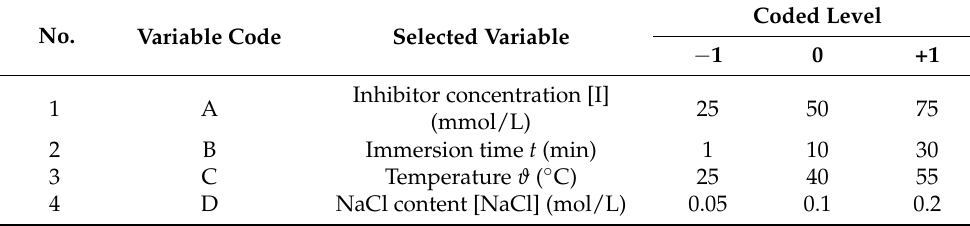
Table 1. The four independent variables with their levels performed with coded values. No.